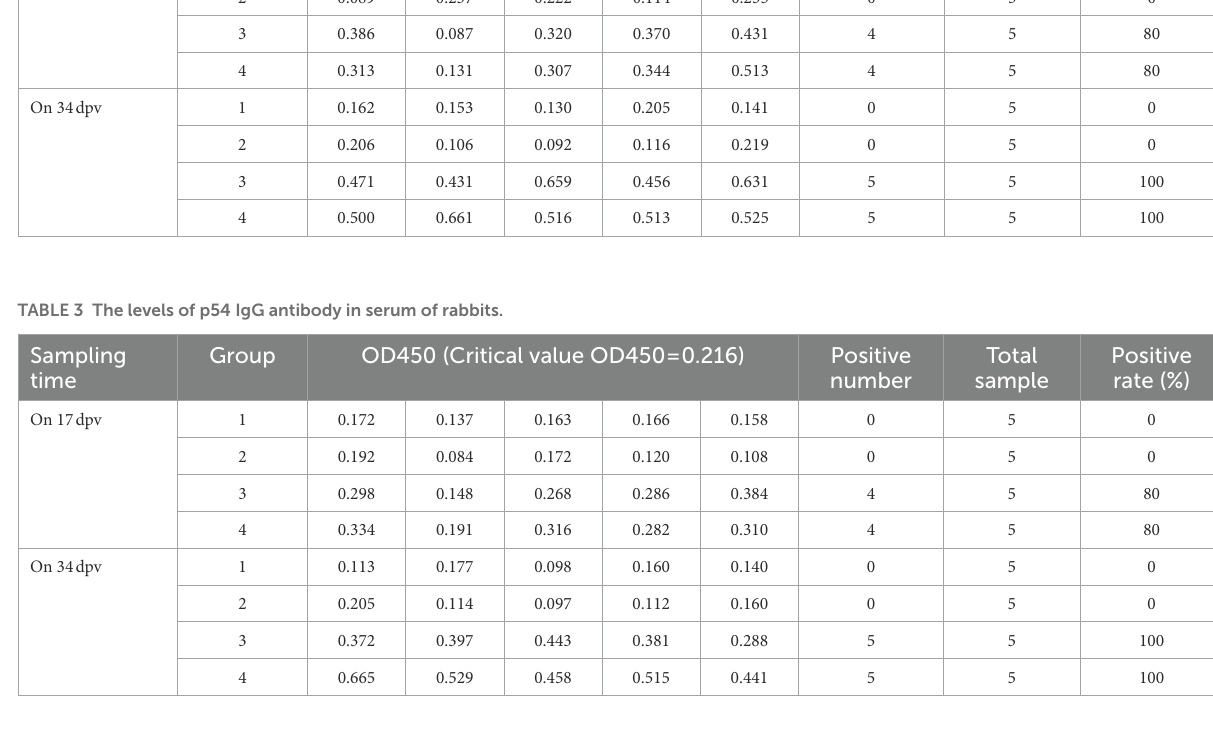
TABLE 4 The levels of p72 IgG antibody in serum of